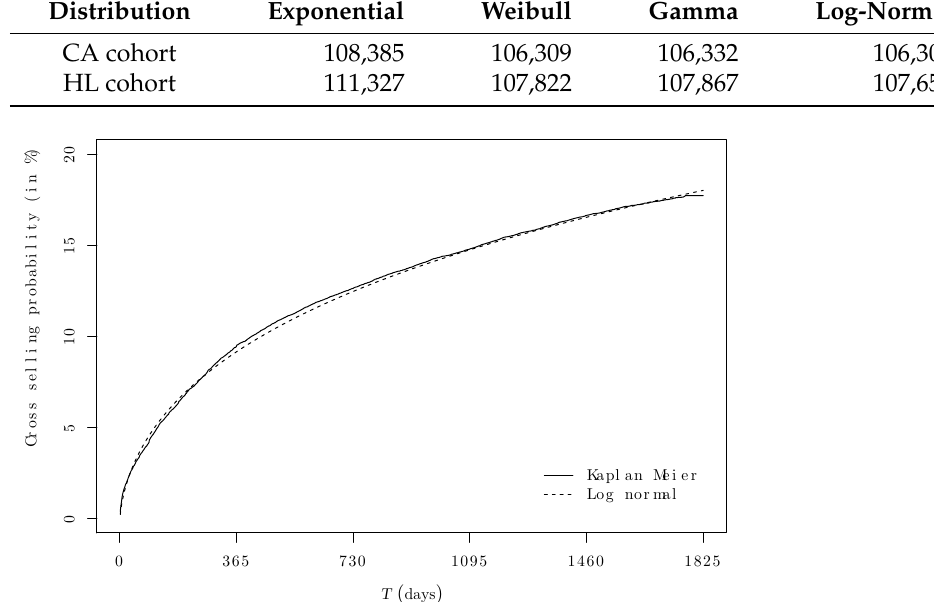
Table 5. Goodness-of-fit statistics (BIC) of the cross-selling times T for the HL cohort. Distribution